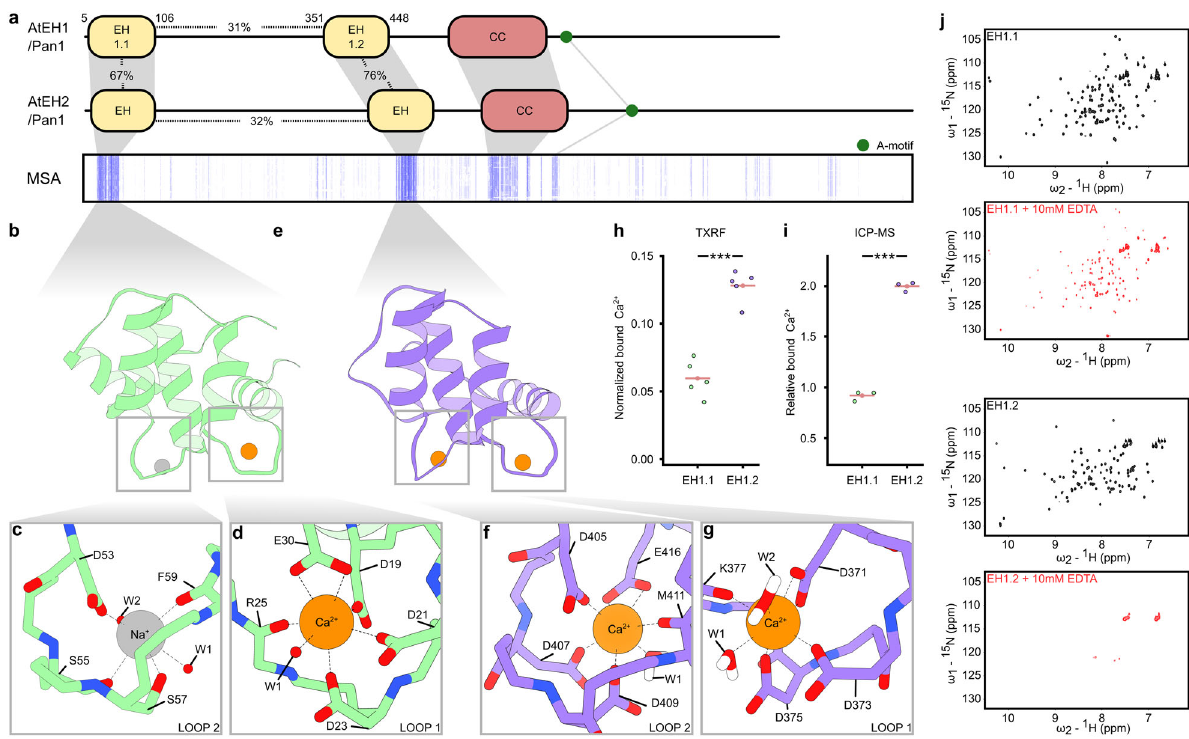
Fig. 1 EH domains of AtEH1/Pan1 differ in their Ca 2 + -binding capacities. a Domain organization of AtEH1/Pan1 and AtEH2/Pan1. Both proteins contain two Eps15 homology domains (EH), a coiled-coil domain (CC), and an acidic (A)-motif. A schematic representation of a multiple sequence alignment (MSA), shows strong conservation of the EH domains (blue lines) across the plant kingdom. Percentages indicate the relative number of identical amino acids. b – g Cartoon representation of the X-ray structure of EH1.1 and NMR/all-atom molecular dynamics structure of EH1.2. Ions are shown as orange (Ca 2 + ) or grey (Na + ) spheres. Insets show the ion coordination in each EF-hand loop. Ca 2 + coordinating residues and water molecules (W) are indicated in ( c , d ) and ( f , g ). h Total re fl ection X-ray fl uorescence (TXRF) intensities of Ca 2 + normalized to Cl − of samples containing 2 mM of each EH domain in the presence of 0.5 mM free Ca 2 + . The mean ( n = 5) is indicated as a pink line. Statistical analysis was performed using a two-tailed Welch ’ s t -test ( p = 1.056 × 10 − 4 ). i Ca 2 + concentration relative to the amount of protein as measured by inductively coupled plasma mass spectrometry (ICP-MS) after subtraction of the amount of free Ca 2 + in the medium. The mean ( n = 3) is indicated as a pink line. Statistical analysis was performed using a two-tailed Welch ’ s t -test ( p = 1.046 × 10 − 5 ). j 15 N- 1 H HSQC spectra of each EH domain before (black) and after (red) Ca 2 + chelation by 10 mM